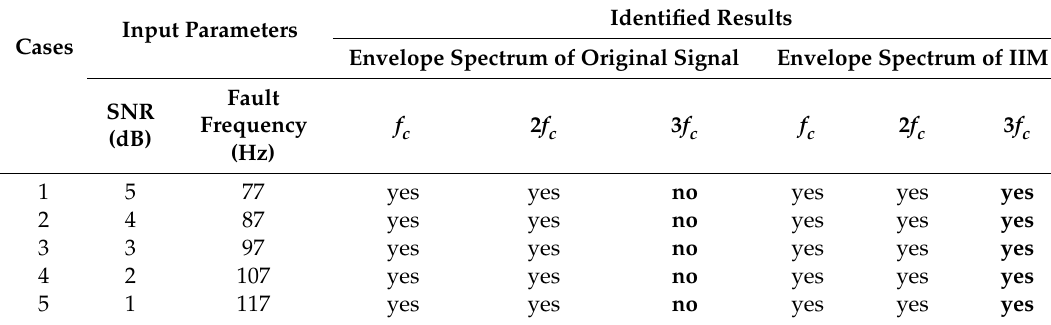
Table 6. Di ff erent simulation signals and corresponding identified